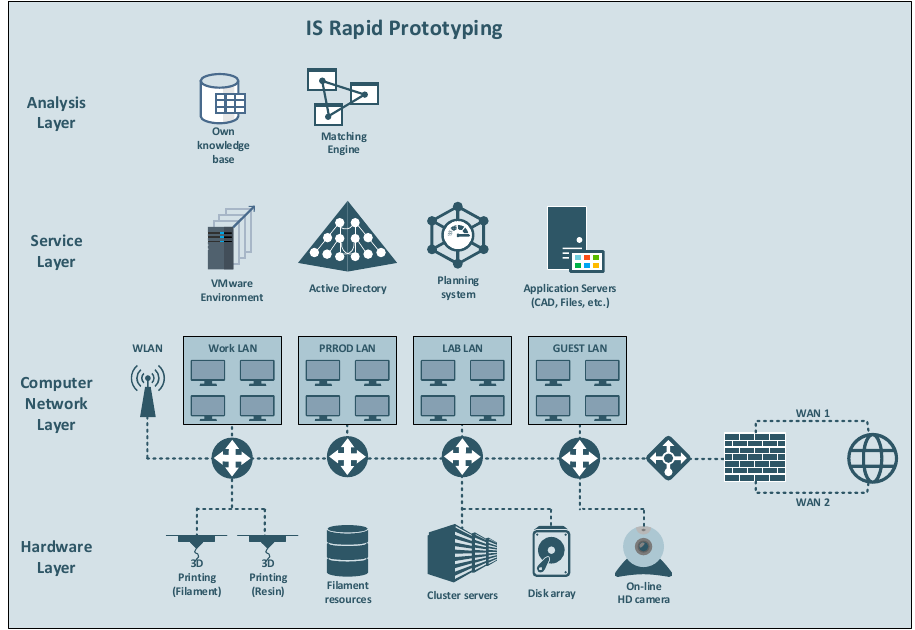
Figure 6. The architecture of the remote prototyping laboratory implemented at InfoSoftware Poland Figure6. ThearchitectureoftheremoteprototypinglaboratoryimplementedatInfoSoftwarePolandLtd. Ltd.